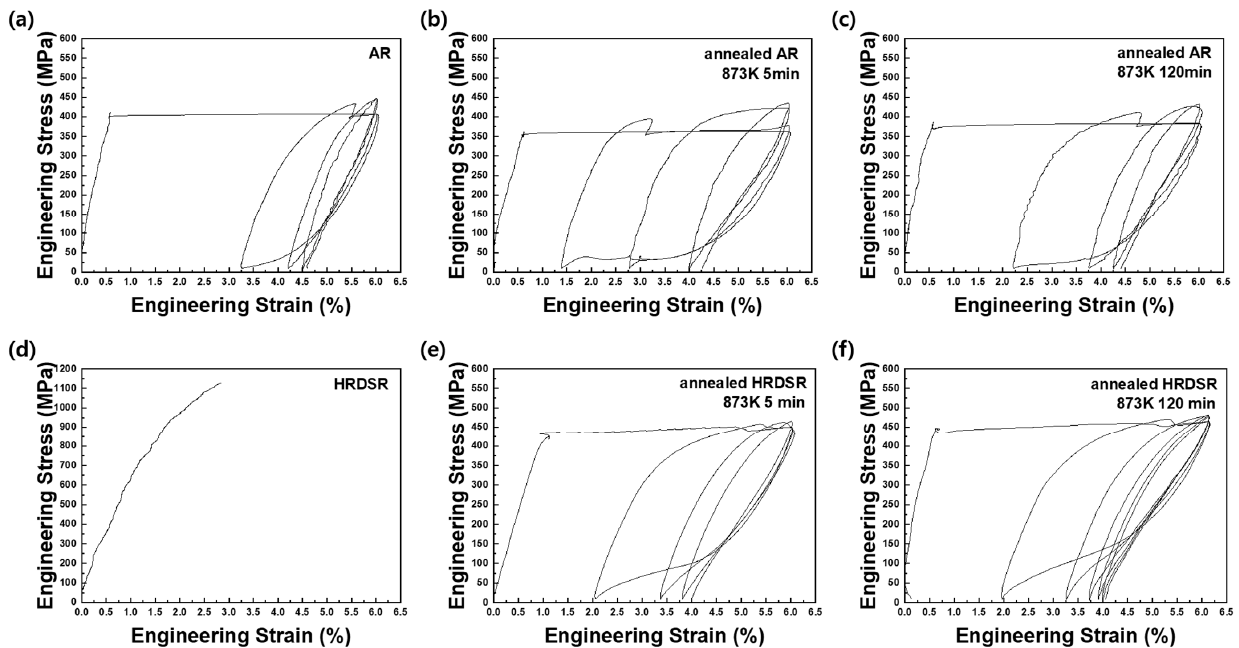
Figure 13. Superelastic cyclic tests up to the strain of 6% for ( a ) the AR sample, ( b ) the AR sample annealed at 873 K for 5 min, ( c ) the AR sample annealed at 873 K for 120 min, ( d ) the HRDSR sample, ( e ) the HRDSR sample annealed at 873 K for 5 min and ( f ) the HRDSR sample annealed at 873 K for 120 min.